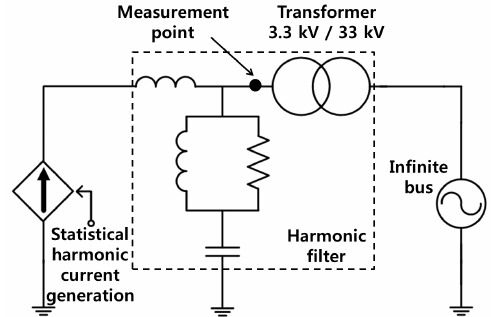
Figure 4. Configuration of the equivalent WT model comprising the equivalent harmonic source, harmonic filter and transformer connected to the infinite